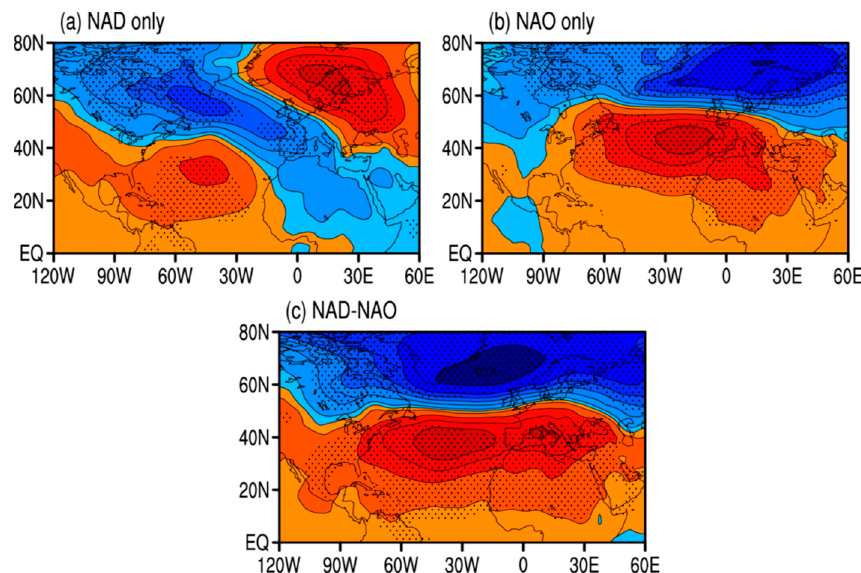
Figure 6. Composite differences of the DJFM-averaged SLP anomalies between ( a ) positive and negative NAD only, between ( b ) positive and negative NAO only, and between ( c ) positive and negative NAD–NAO. Anomalies significant at the 90% confidence level are stippled.